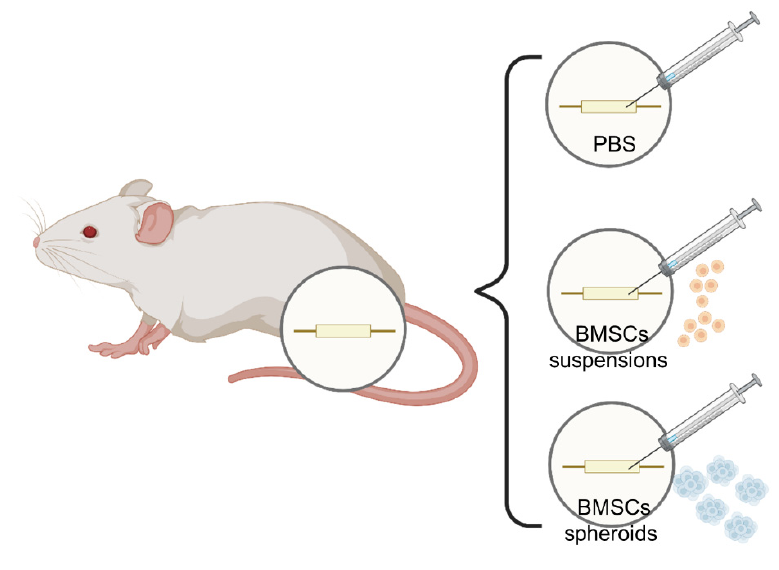
Figure 2. Schematic diagram of each group of nerve conduits and